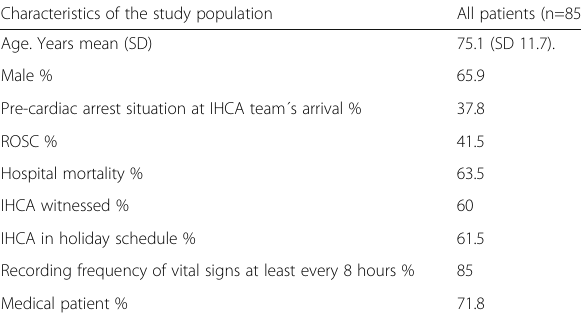
Table 96 (abstract A303). Characteristics of the study population